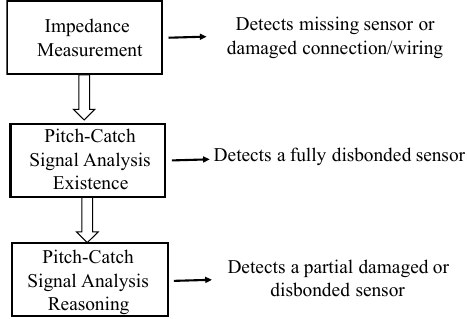
Figure 13. Integrated three-step method to automatically detect faulty sensors.